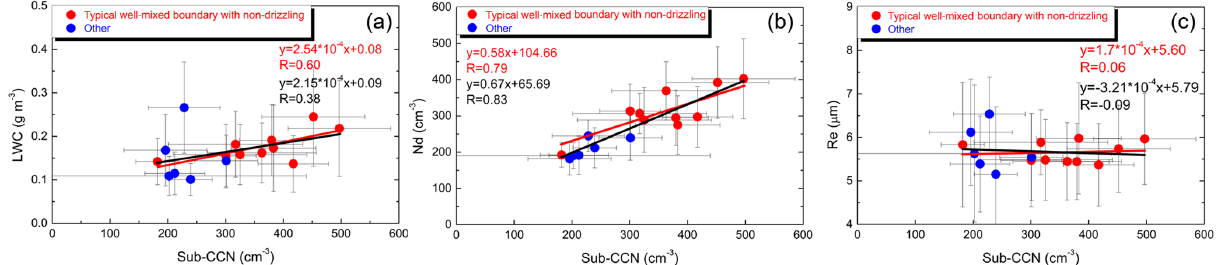
Figure 3. (a) LWC (gcm − 3 ), (b) N d (cm − 3 ), and (c) R e (µm) as a function of sub-cloud CCN concentrations (SS = 0 . 2%) for all 16 non- drizzling flights. The error bars through these symbols indicate the standard deviation. Red symbols are the cases with typical well-mixed BL discussed in Zheng et al. (2011), and blue symbols are for other cases. Red (black) texts are the correlation coefficient for typical well-mixed cases (all